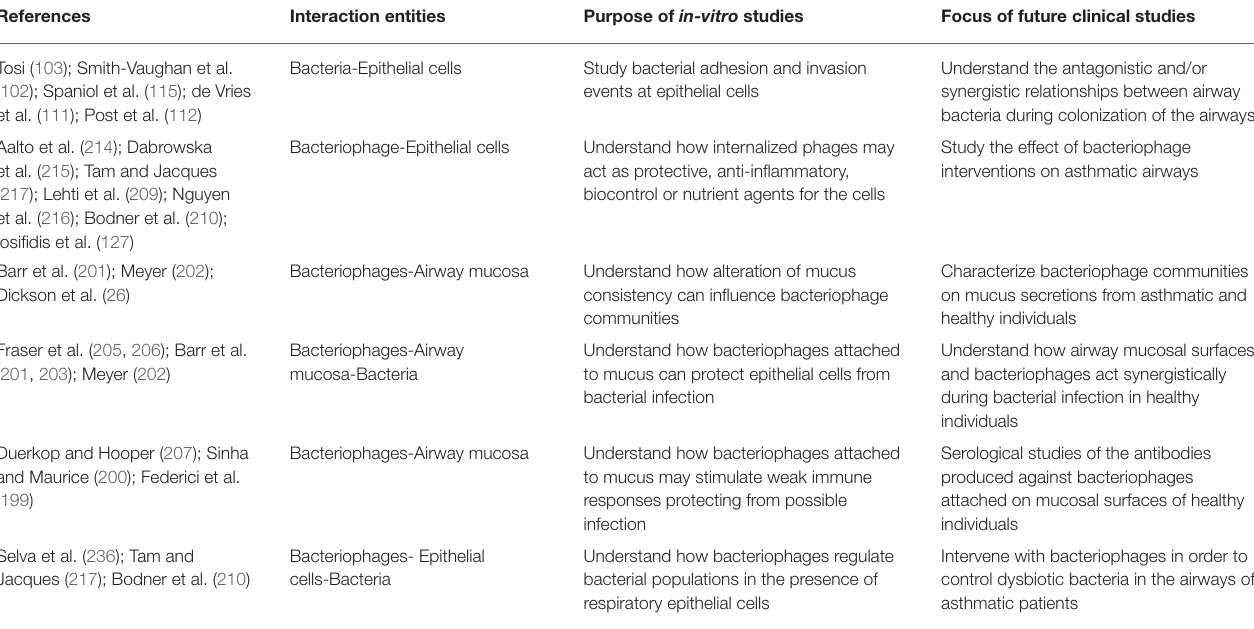
TABLE 2 | Novel ideas that are coming up from current in-vitro studies focused on the interaction between bacteriophages, bacteria and airway mucosa and proposed future in-vivo studies that can be significant for clinical